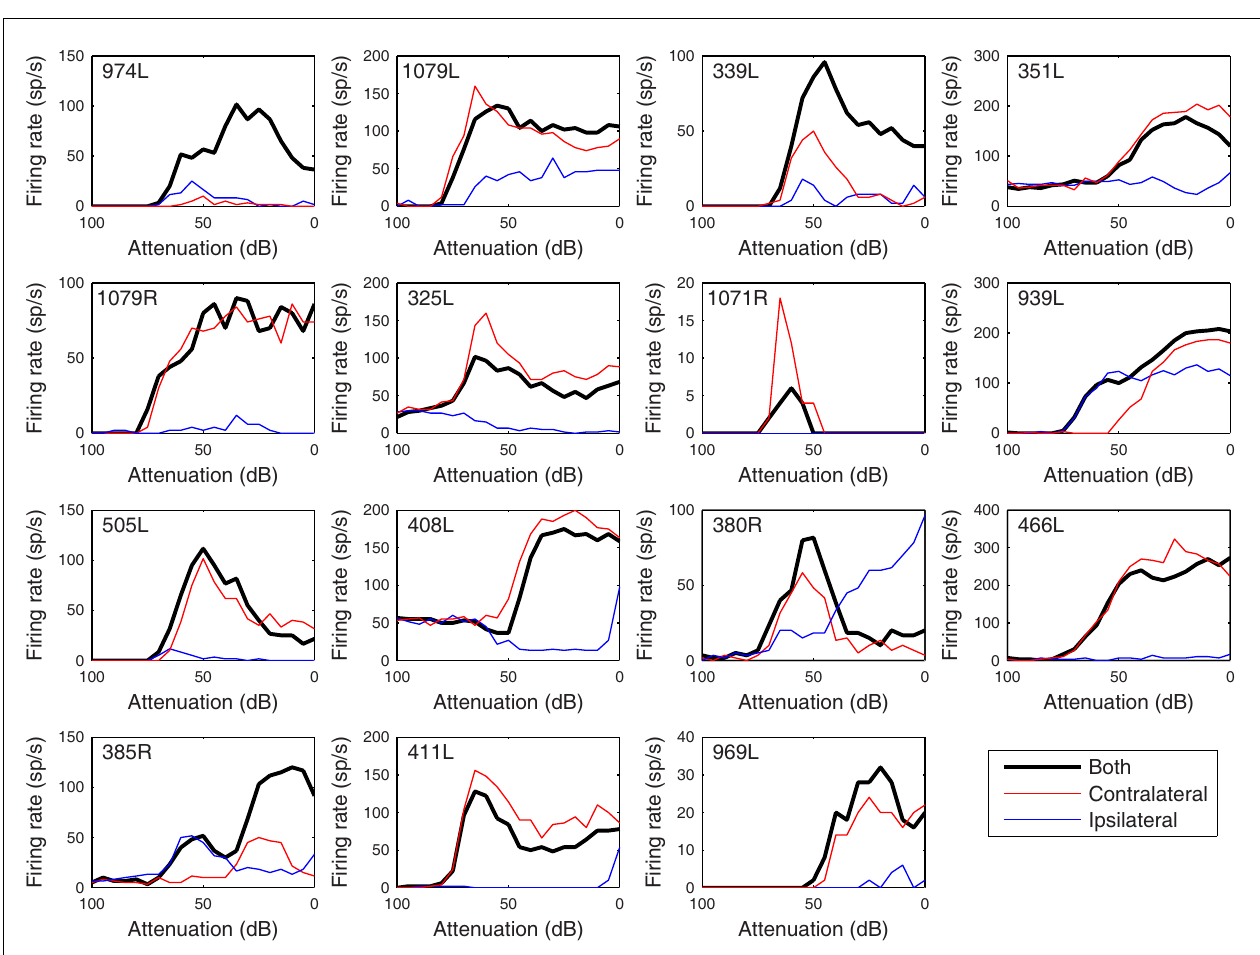
FIGURE 11 | Rate versus level functions in response to 50ms CF tones arranged in the same order as previous figures. The black curves show responses to binaural presentation, red to contralateral, and blue to ipsilateral.